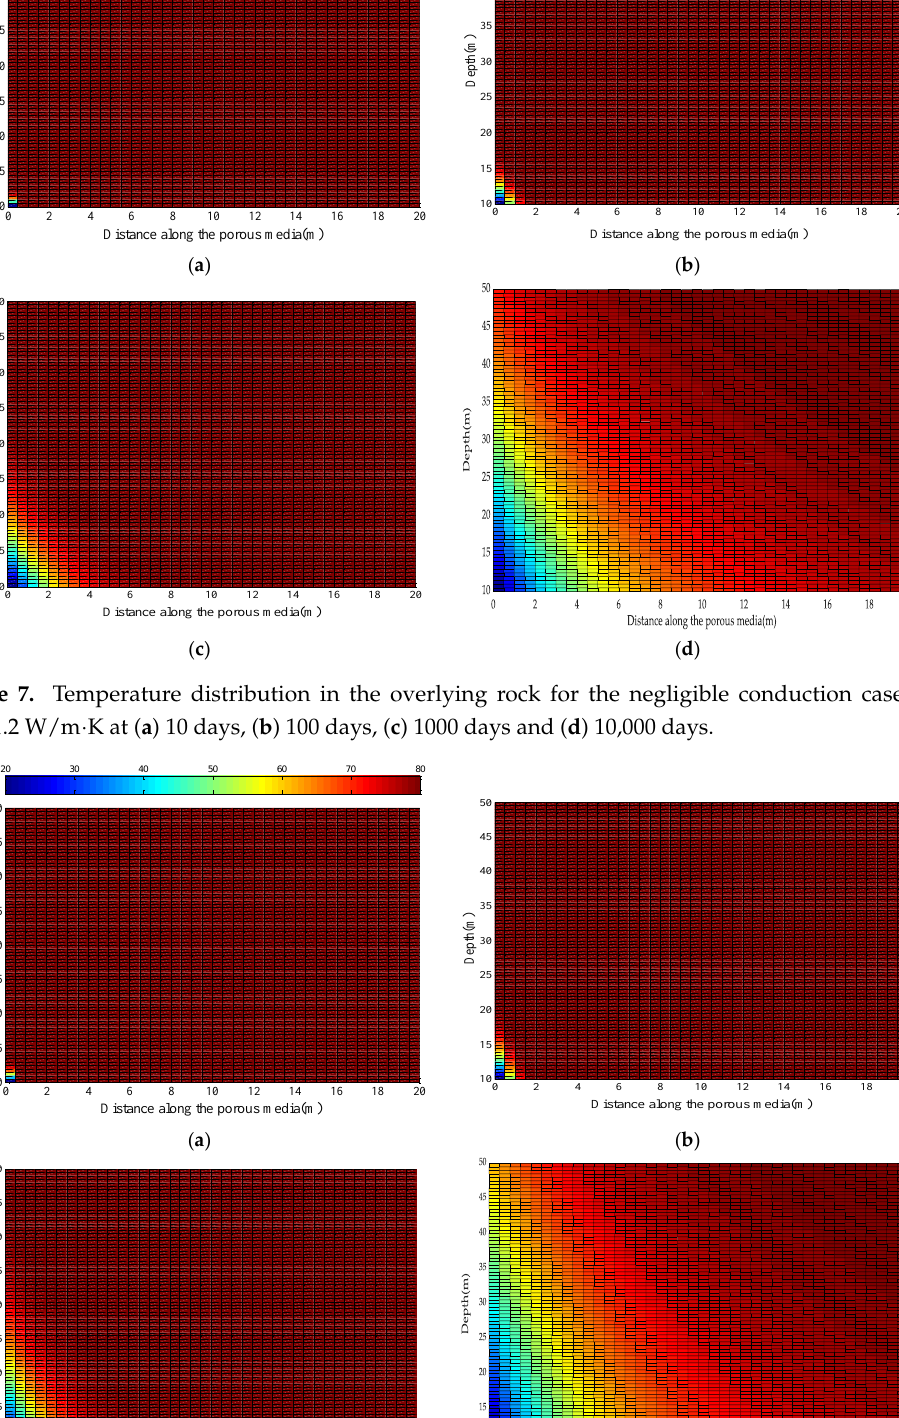
Figure 8. Temperature distribution in the overlying rock for the negligible conduction case for λ 1 = 2.5 W/m · K at ( a ) 10 days, ( b ) 100 days, ( c ) 1000 days and ( d ) 10,000 days.